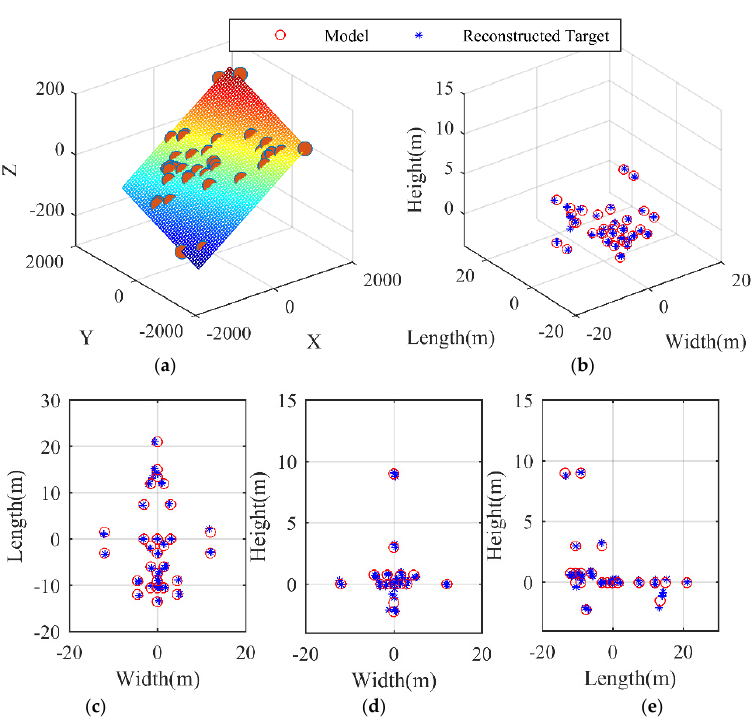
Figure 6. 3D reconstruction results 𝑑𝑣,𝑑ℎ = 4 𝑚 . ( a ) Regression plane of parameter estimation in Equation (25). ( b ) 3D reconstruction result of the airplane. ( c ) Range–horizontal direction view ( 𝑦 (cid:2869) − 𝑦 (cid:2870) ). ( d ) Range–vertical direction view ( 𝑦 (cid:2870) − 𝑦 (cid:2871) ). ( e ) Vertical–horizontal direction view ( 𝑦 (cid:2869) − 𝑦 (cid:2871) ).